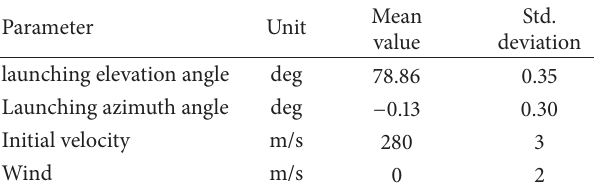
Figure 18: The deflection angle and control phase histories of the controlled trajectory with optimized trajectory correction scheme. Table 2: Initial conditions and